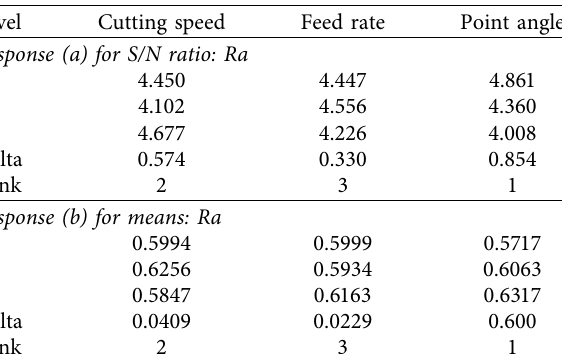
Table 5: Response table for Ra.